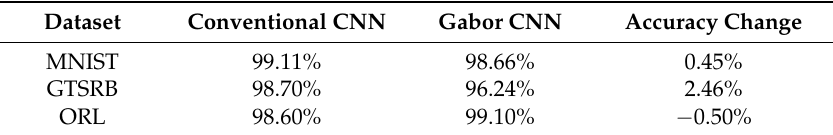
Table 4. Accuracies of networks.